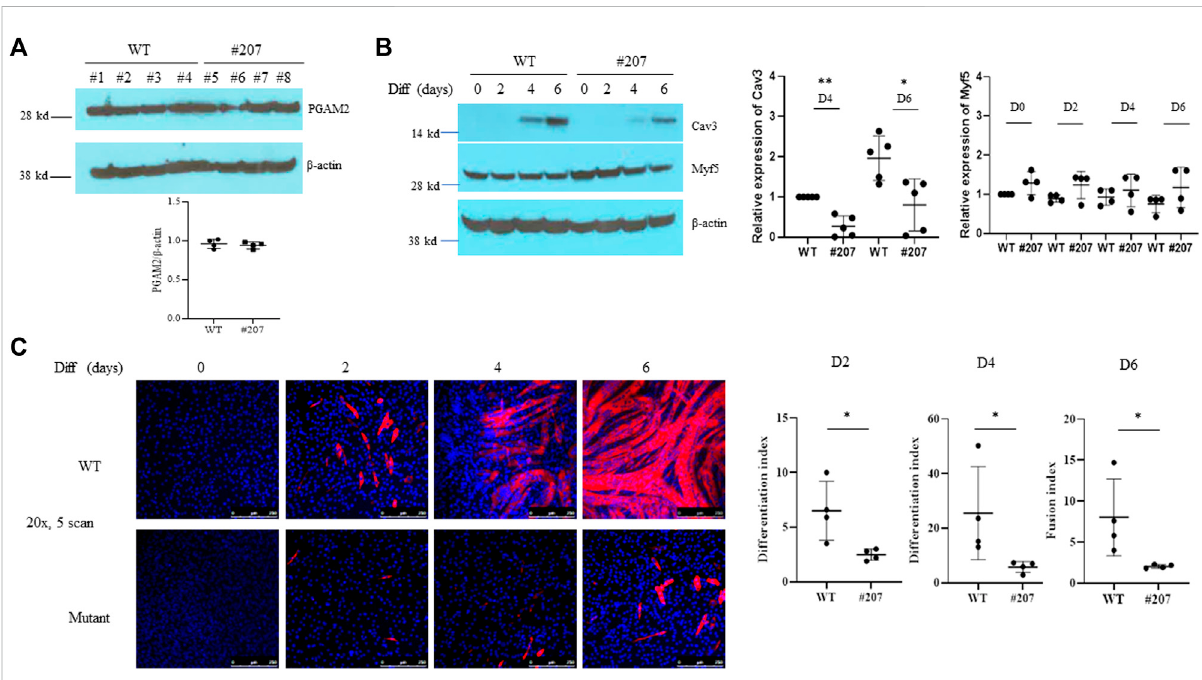
FIGURE 3 The PGAM2-K176R mutation impairs myogenic differentiation. (A,B) Western blot analysis of whole-cell lysates from WT and C2C12 K176R/K176R cells(#207)atdifferentiationday(d)0(i.e.,undifferentiated),d2,d4andd6.Cellswereplatedandcultured ingrowthmedium(GM)overnightin6-cm plates and then switched to differentiation medium (DM). DM was replenished every 2 days. β -Actin was used as a control. * p < 0.05, ** p < 0.01 vs . WT. (C) Immuno fl uorescence staining for MHC was performed in WT and C2C12 K176R/K176R cells at differentiation days as indicated. Red,